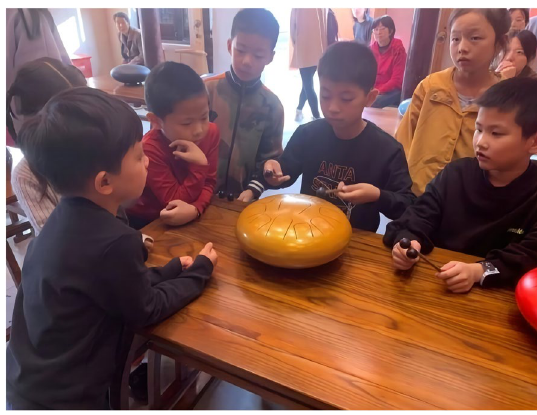
Fig. 10 Students learning the fish drums (Source: provided by the Digang Fish